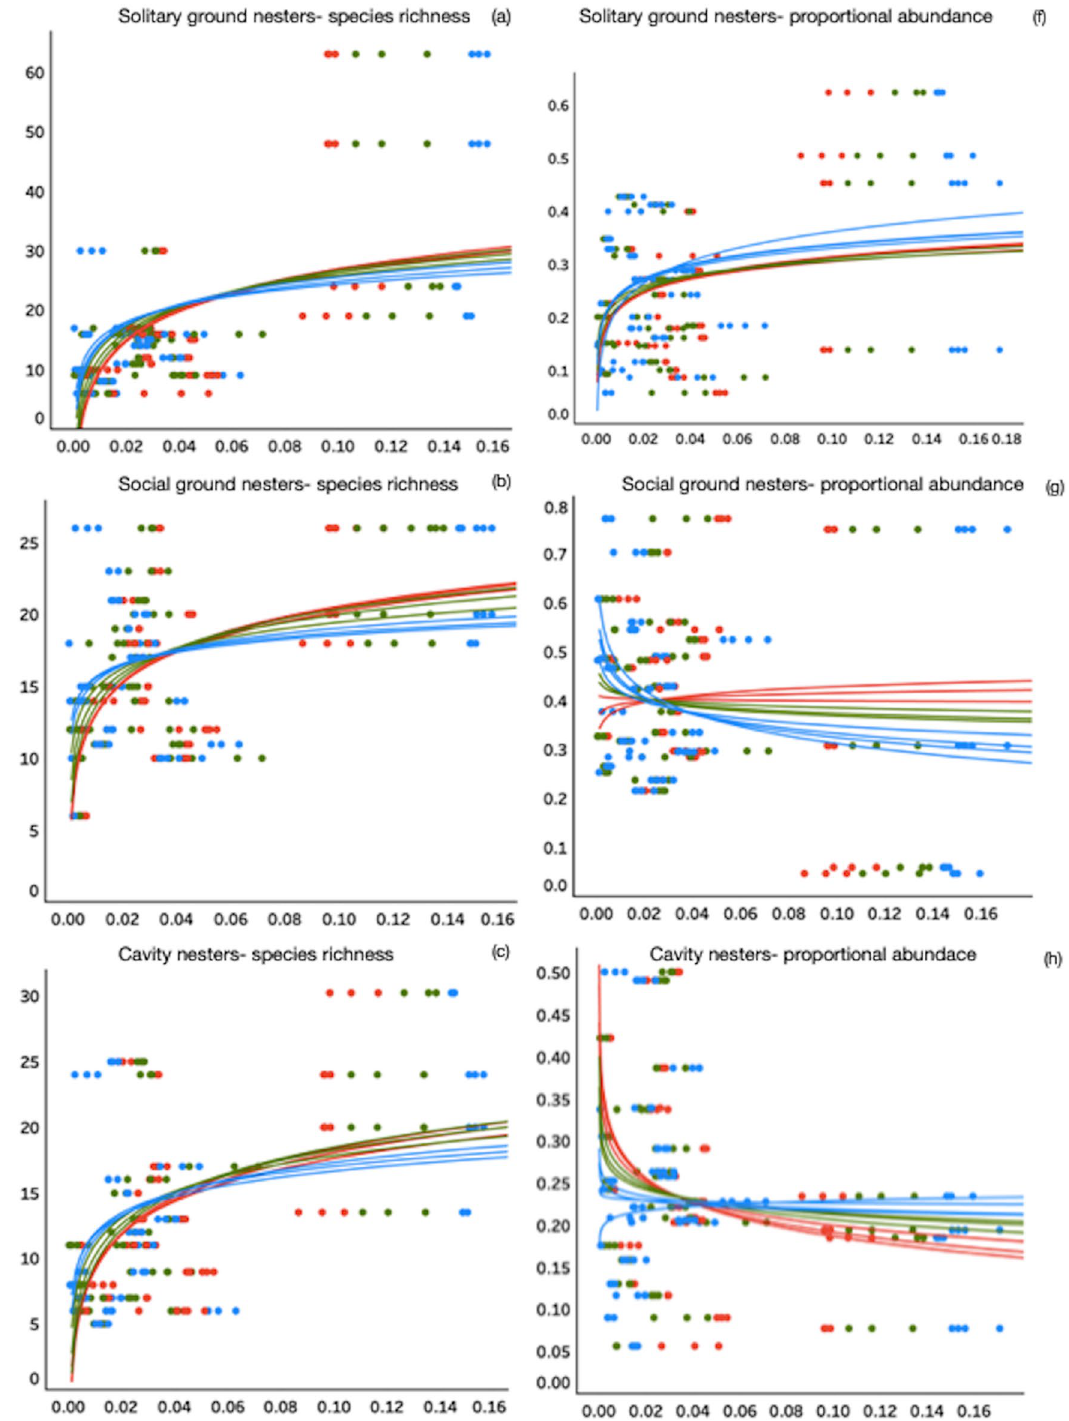
Figure 3. Relationship between the proportion of pollinator habitat within a landscape in Southern Ontario and community parameters, species richness and proportional abundance of solitary ground nesting bee species ( a , f ); social ground nesters ( b , g ); cavity nesters ( c , h ); bumblebees ( Bombus spp.) ( d , i ); cleptoparasites ( e , j ). Logarithmic trendlines in blue are for spatial scale < 500 m, green trendlines represent spatial scale between 500 and 1500 m, and red trendlines are distances > 1500 m. Regression coefficients and p values associated with each spatial scale trendline and functional guild community parameter can be found in Table